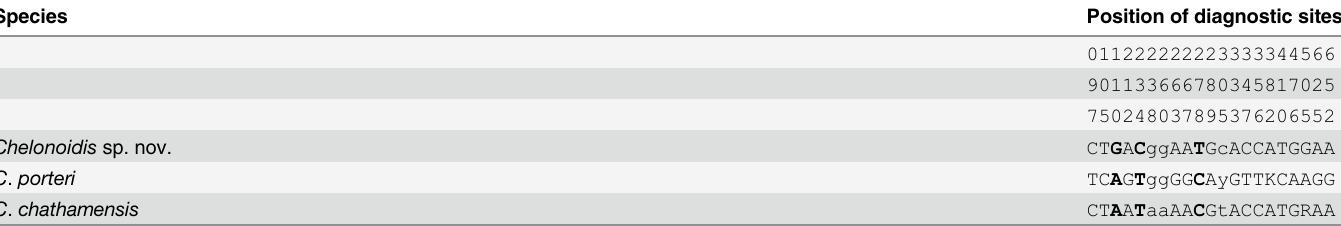
Table 2. Diagnostic sites distinguishing Chelonoidis sp. nov. (Cerro Fatal — Santa Cruz), C . chathamensis (San Cristóbal) and C . porteri (Reserva — Santa Cruz). The position of diagnostic locations is relative to the GenBank record AY956622 for porCF1 from Cerro Fatal. Capital letters (nucleotides): diagnostic sites between Chelonoidis sp. nov. (Cerro Fatal) and C . porteri (Reserva); small letters (nucleotides): diagnostic sites between Chelonoidis sp. nov. (Cerro Fatal) and C . chathamensis (San Cristóbal); bold capital letters (nucleotides): diagnostic sites between Chelonoidis sp. nov. (Cerro Fatal) and both C . porteri (Reserva) and C . chathamensis (San Cristóbal). K = G/T, R = A/G, Y = C/T polymorphisms.